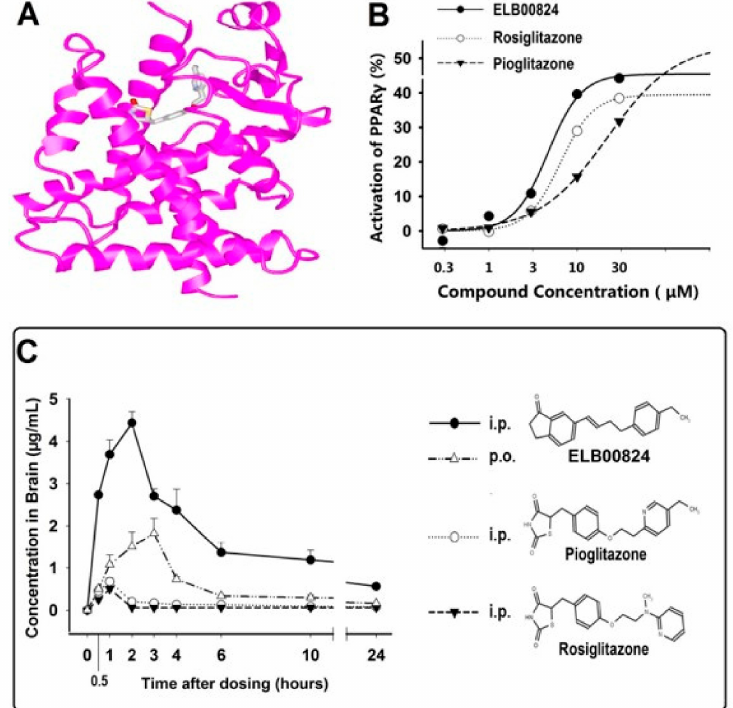
Figure 2. ( A ) Nuclear magnetic resonance (NMR) structural confirmation of EL00824. ELB00824 (grey structure) binds tightly with PPAR γ (pink ribbon). ( B ) ELB00824 exhibits the highest in vitro PPAR